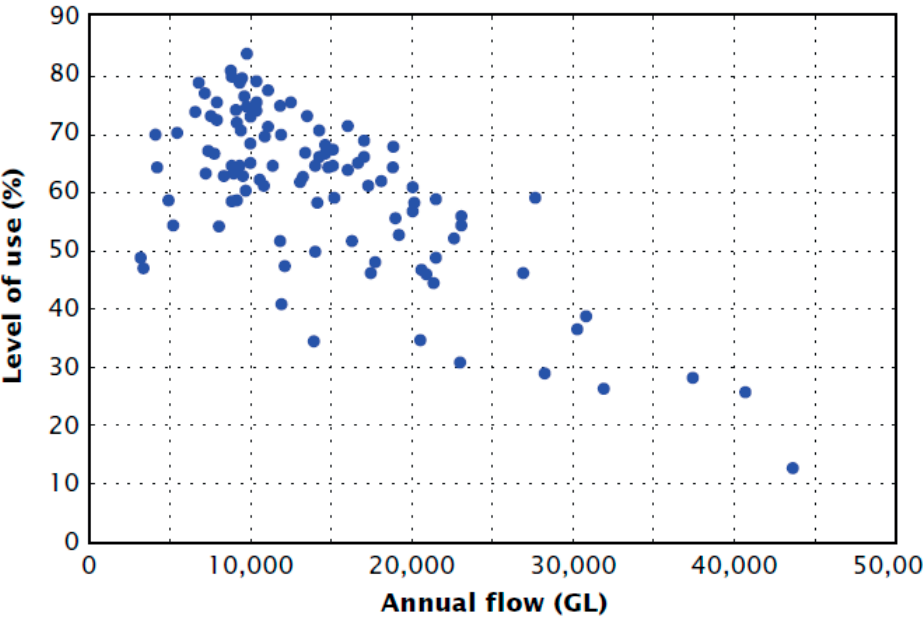
Figure 3. Predicted annual level of surface water use across the Basin versus natural river flow. Annual flow and water use were modelled using water plan river models for 2006 (before the Basin Plan), and run over the 1896–2006 period. Data from CSIRO [53].